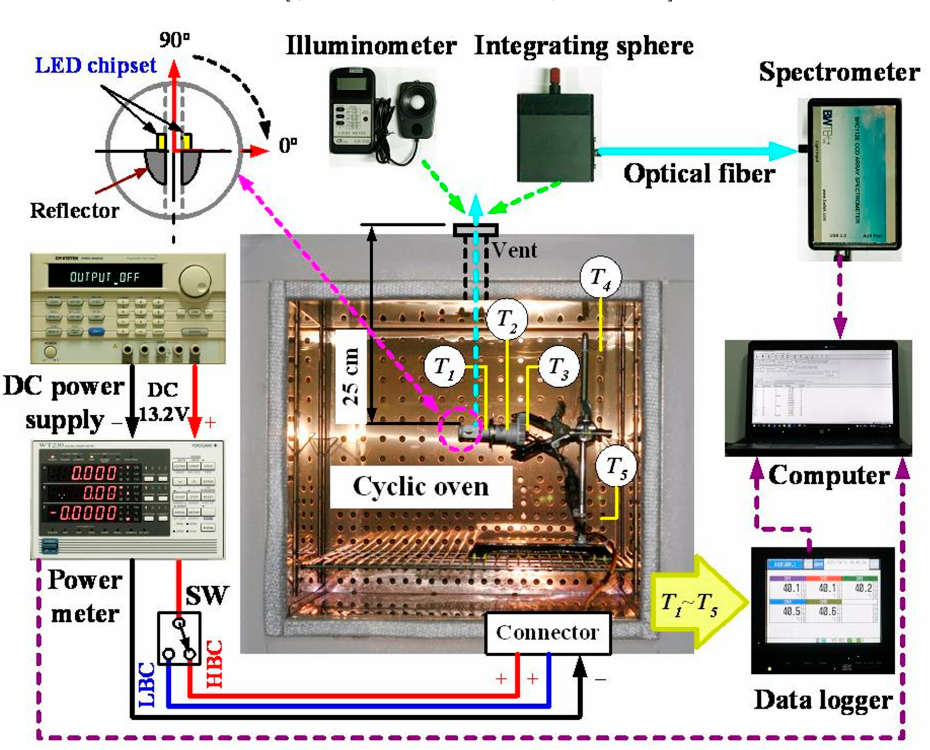
Figure 5. Schematic diagram of the experimental measurement system.